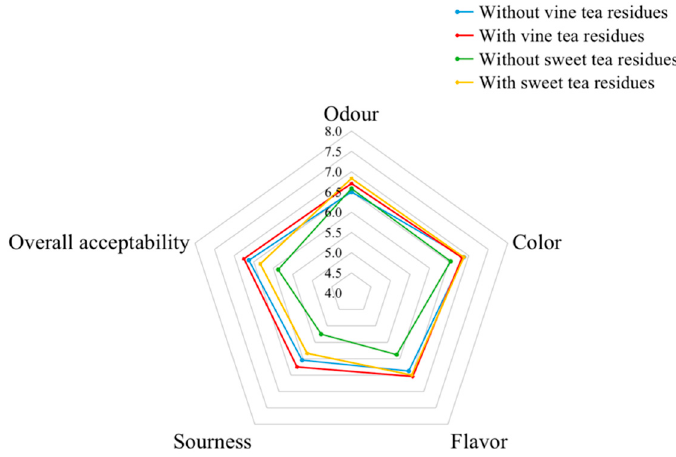
Figure 8. Sensory property of kombucha beverages.